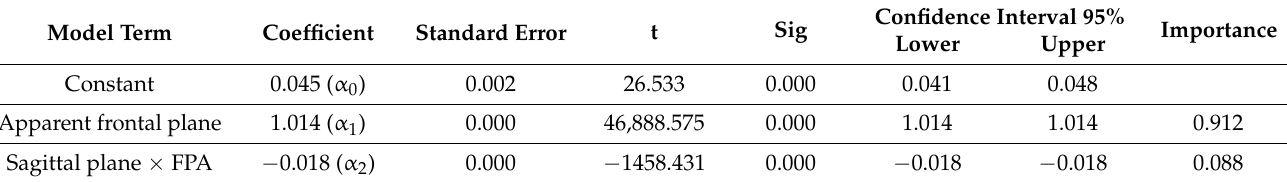
Table 2. Results of regression Model 2.